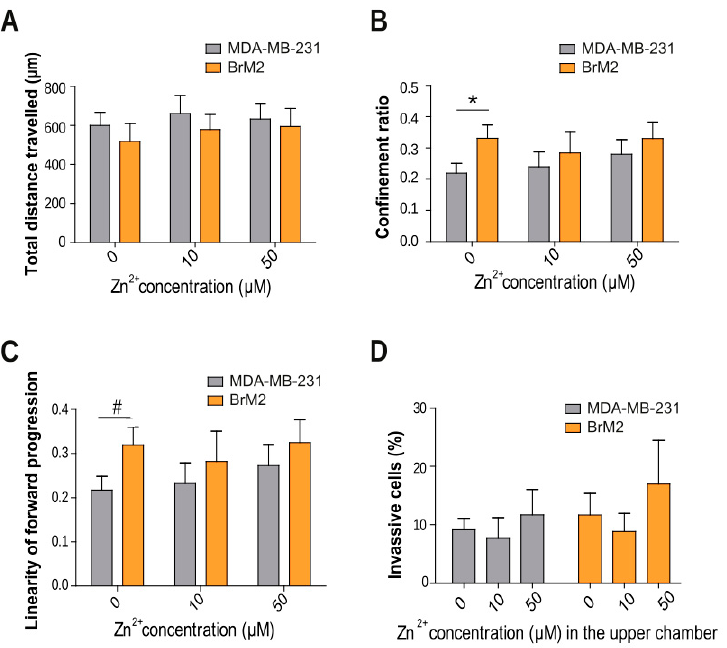
Figure 2. Characterization of migration, motility, and invasion of MDA-MB-231 and BrM2 cells in different zinc concentrations. Comparison of representative cell migration parameters, including ( A ) total distance travelled, ( B ) confinement ratio (net distance/total distance travelled), and ( C ) lin- earity of forward progression ((net distance/total track time)/mean speed) ( n = 17–26); * p < 0.05 using t -test, # p < 0.05 using Mann–Whitney test. ( D ) Percentage of cells, incubated at different zinc concentrations, that invaded the bottom chamber, with normal media (n = 4).